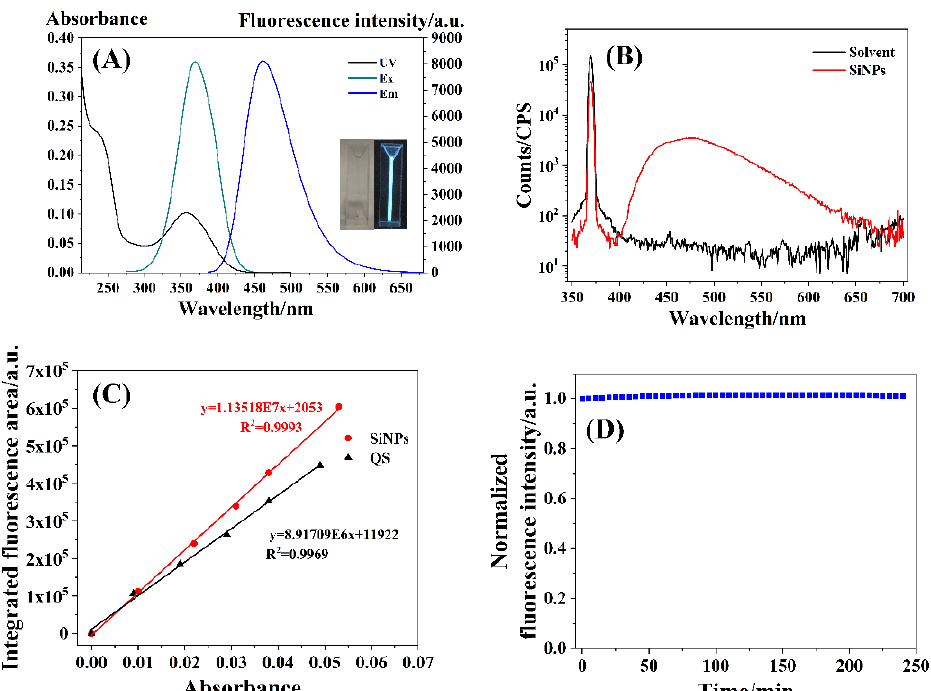
Figure 3. ( A ) UV–vis absorption spectrum (UV), fluorescence excitation spectrum (Ex), and fluo- rescence emission spectrum (Em) of the as-prepared SiNPs. Inset: the as-prepared SiNPs aqueous solution under white light (left) and 365 nm UV light (right); ( B ) the absolute fluorescence quantum yield spectra; ( C ) the relative fluorescence quantum yield spectra; ( D ) optical stability.